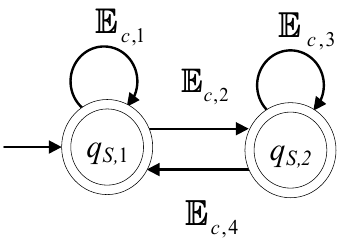
Figure 5. State diagram of S .